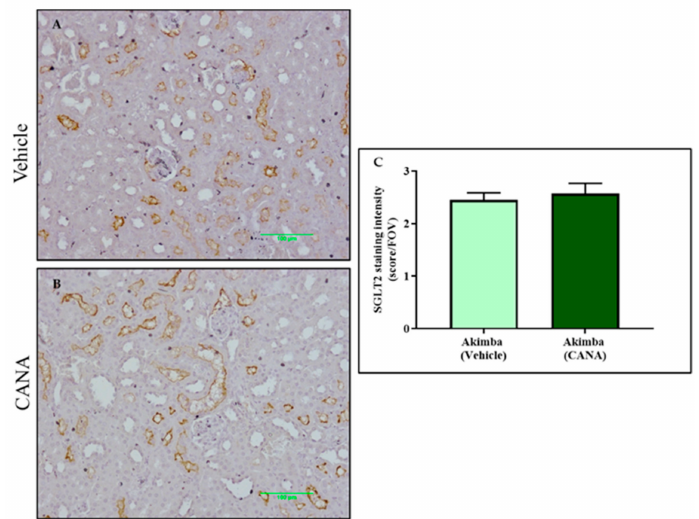
Figure 8. CANA was not associated with an increased SGLT2 protein expression in the kidneys of diabetic Akimba mice. Representative images of SGLT2-stained kidney tissues from diabetic Akimba mice treated with Vehicle ( A ) and diabetic Akimba mice treated with CANA ( B ) and SGLT2 quantification ( C ). Scale bar = 100 µ m; n = 5–6 mice/group; CANA: